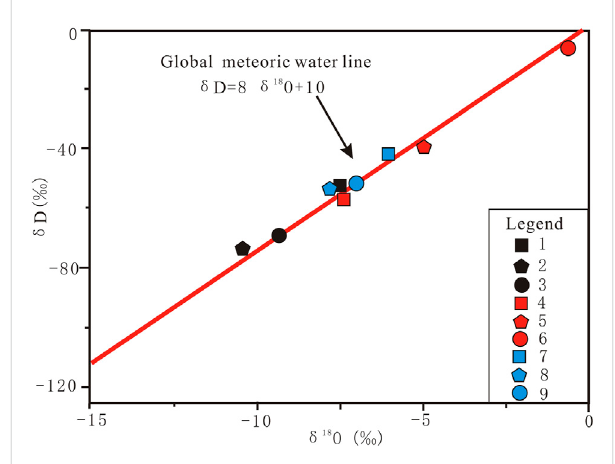
FIGURE 5 Relationships between the δ D and δ 18 O values of the No.